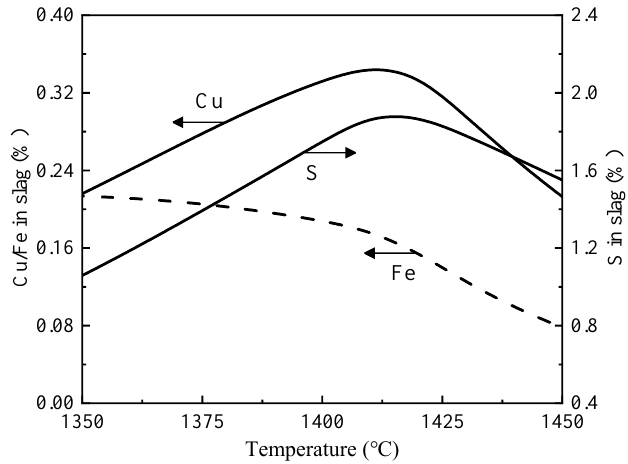
Figure 9. Effect of temperature on the copper and iron contents in the reduced slag, predicted by FactSage 8.2: 13% carbon and 5% CaO.